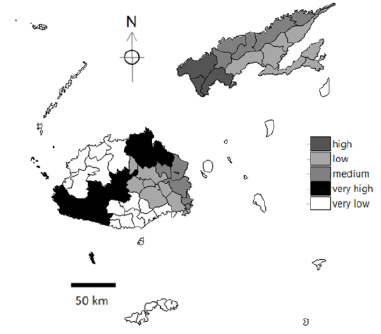
Figure 15a. LUI of farms of 20-50ha. Figure 15b . LUI of farms of 50-100ha farm size ranges.